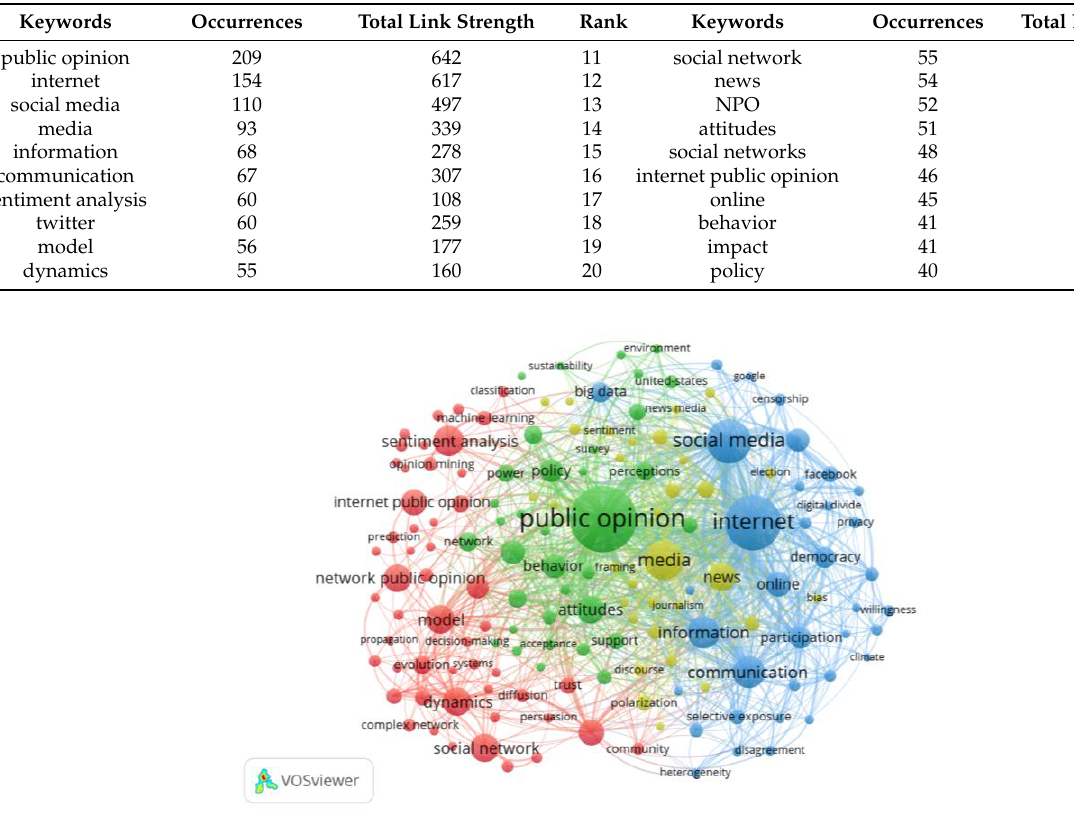
Table 7. The top 20 keywords of the NPO studies, 1990–2020.